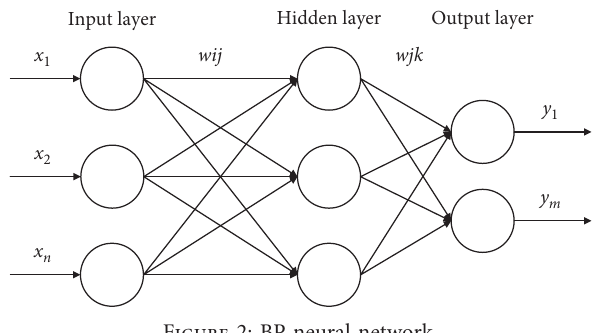
Figure 2: BP neural